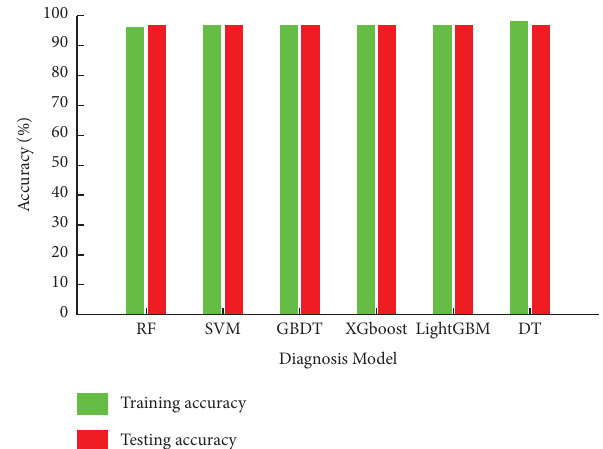
Figure 13: Comparison of fault diagnosis result under diferent diagnosis models.